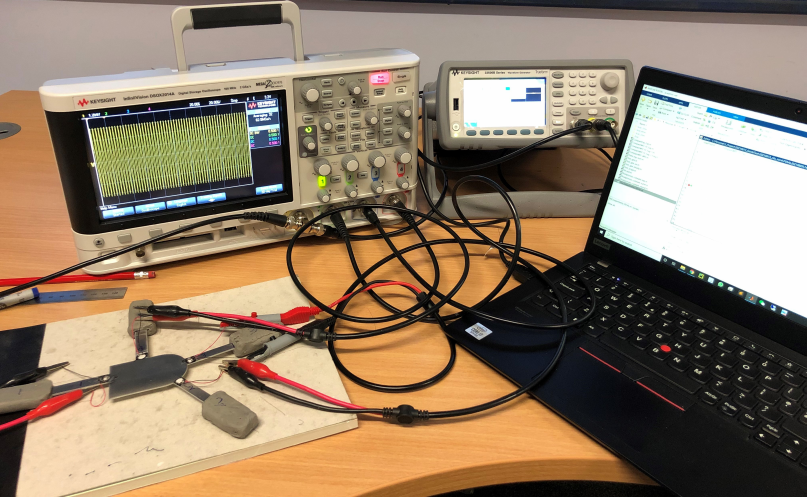
Figure 4. Experimental setup, comprising a laptop, an arbitrary waveform generator, and an oscillo- scope connected to the PZT transducers, attached in turn to the aluminium